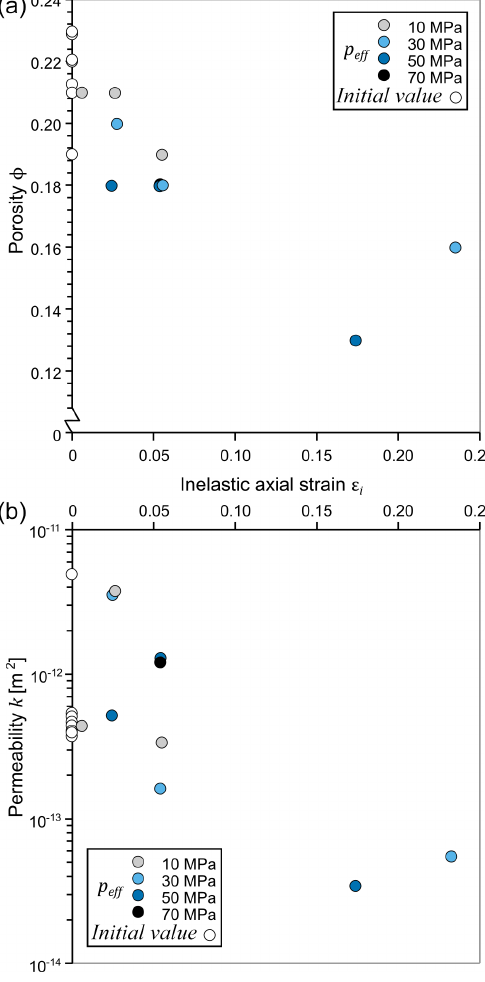
Figure 3. Change in physical properties after accumulating inelastic axial strain. (a) Pre- and post-deformation porosity (the latter calcu- lated by φ + (cid:49)φ i ) versus inelastic strain. Effective pressure is indi- cated by the symbol colour. (b) Pre- and post-deformation gas per- meability as a function of the inelastic strain accumulated by each sample. Effective pressure is indicated by colour as in panel (a) : note, however, that the value of p eff corresponds to deformation, whereas permeability was measured in each case at p eff =